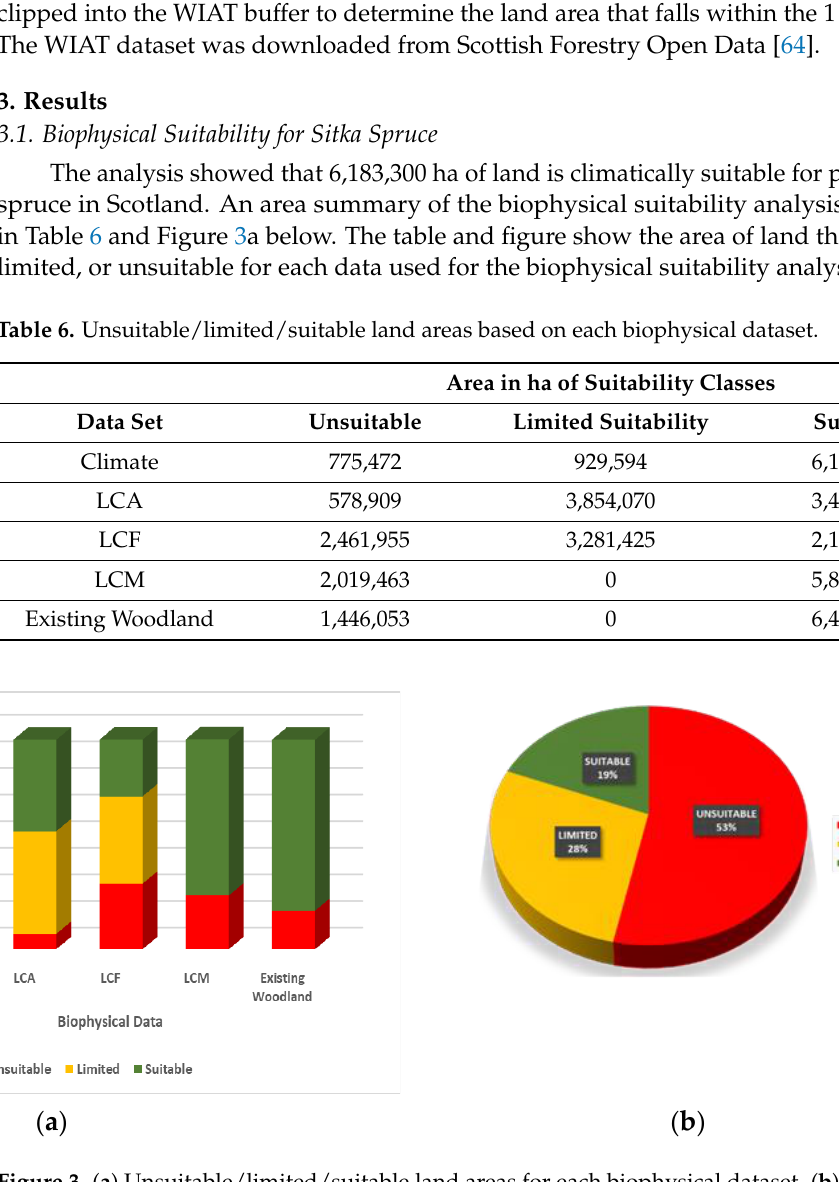
Figure 3. ( a ) Unsuitable/limited/suitable land areas for each biophysical dataset. ( b ) Percentage of land area in Scotland biophysically unsuitable/limited/suitable. land area in Scotland biophysically